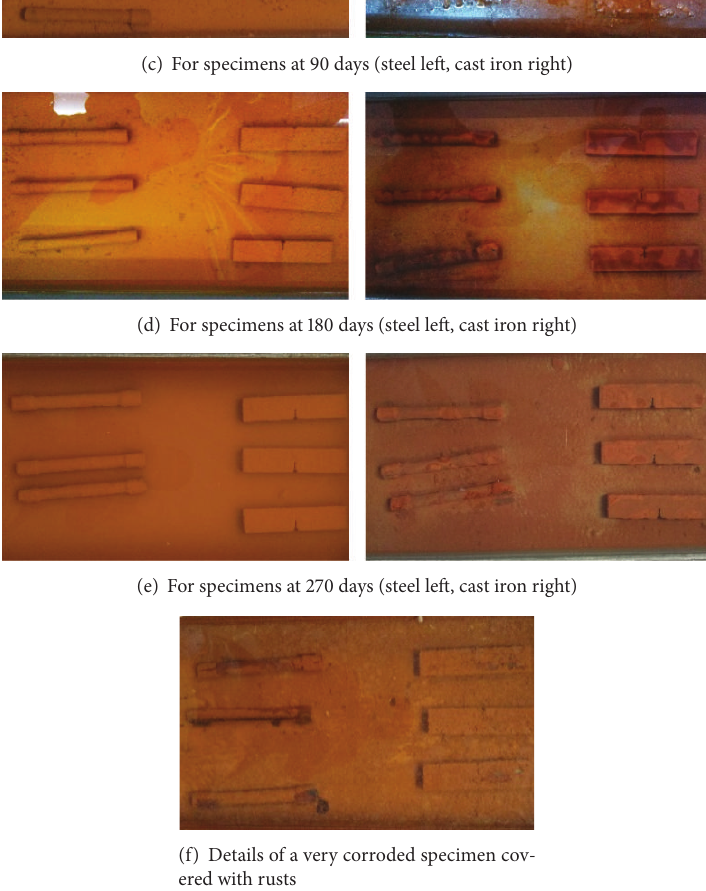
Figure 7: Photos of corroded specimens at different exposure